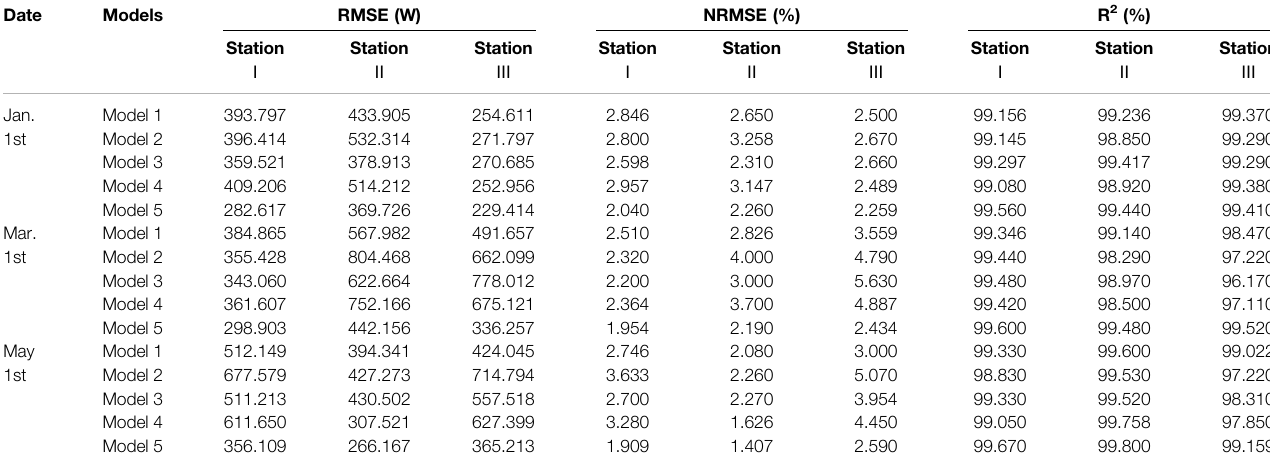
TABLE 5 | RMSE, NRMSE, and R 2 of models on different prediction